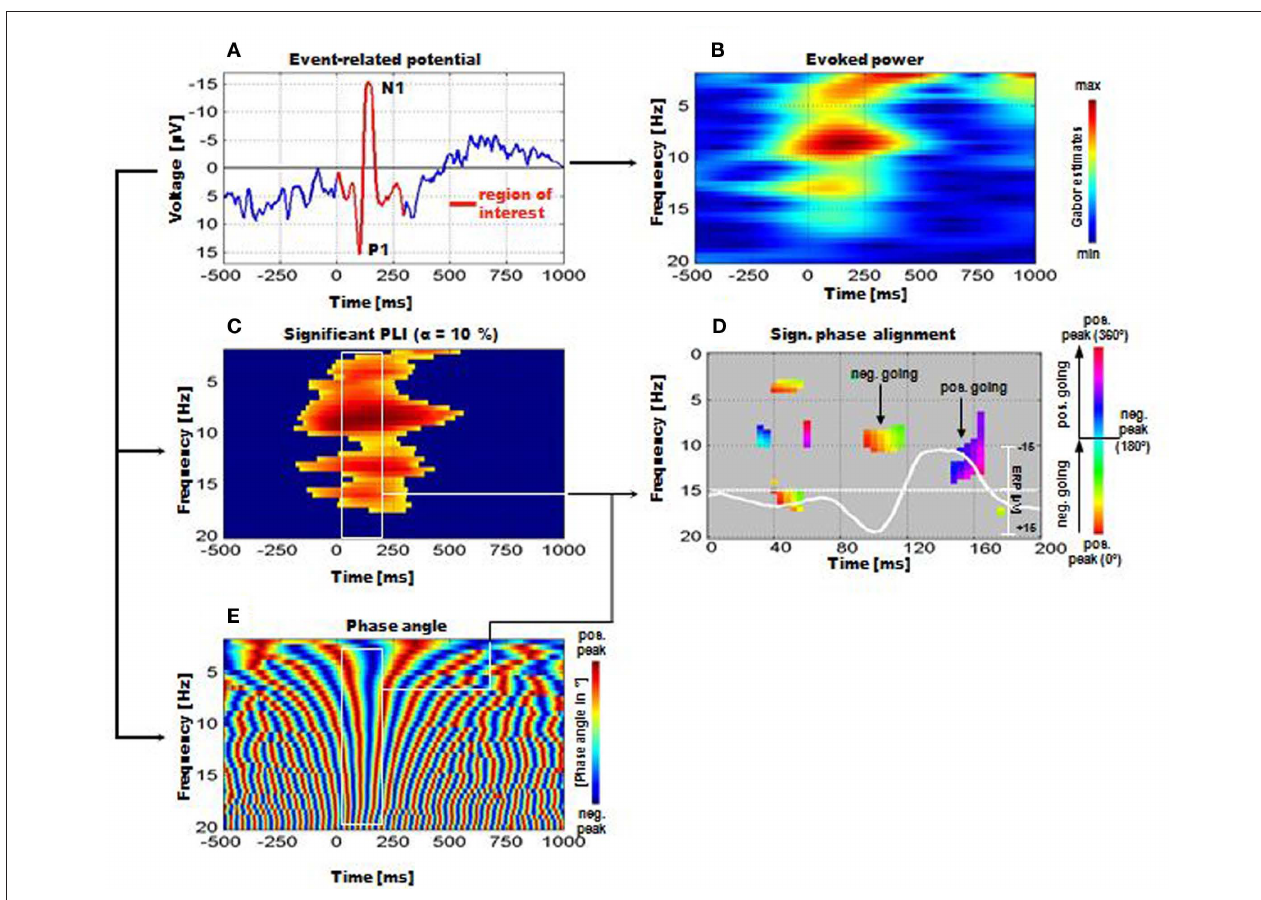
Figure 3 | instantaneous phase alignment (iPA) as analyzed by gruber et al. (2005) for the data of a memory retrieval task. (A) Example of the ERP with the P1-component. (B) The frequency characteristic of the ERP is reflected by a measure termed evoked power. It represents the filtered ERP. (C) Significant phase locking can be observed in a broad frequency range. (D) Significant IPA can be observed particularly for the time window of the P1 and N1. The white line represents the ERP. For the P1, phase alignment is around